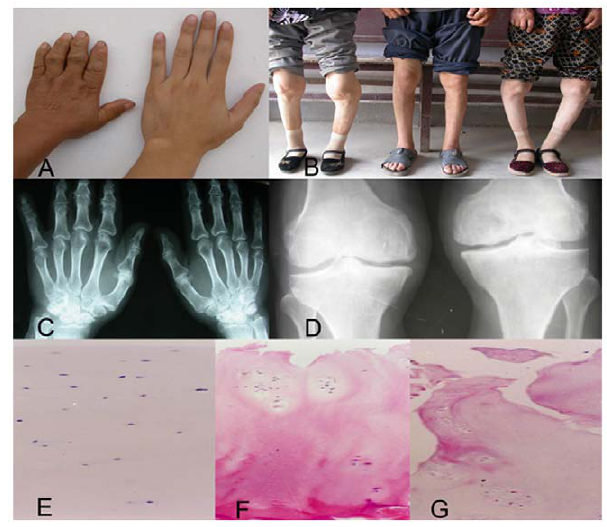
Figure 2. Characteristics of Kashin-Beck disease (KBD). A&B, images of left hand(A, left male patient aged 55 years) and knees (B, left female patient aged 44 years, middle male patient aged 42 years, right female patient aged 49 years) from representative patients with grade II or III KBD; C, radiographic images of left and right hands of a KBD patient exhibiting shortened phalanges, enlarged bone ends of phalanges, and narrowed joint space; D, radiographic images of left and right knees of a KBD patient exhibiting widened and narrowed joint space; E–G, hematoxylin and eosin staining of adult articular cartilage from a healthy subject (E) and two patients with grade II (F) or III (G) KBD (original magnification 6 100).